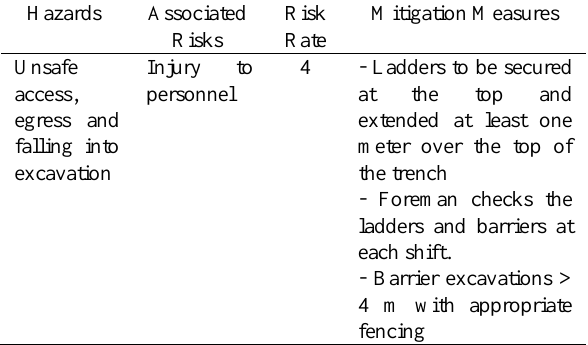
Table2. An example of risk rating performed for trenching activity based on the H&S standards